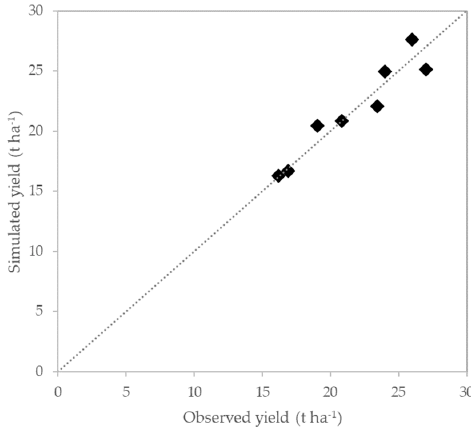
Figure 4. Simulated versus observed dry root yield at harvest for the FARM1-8 datasets used for the model validation.